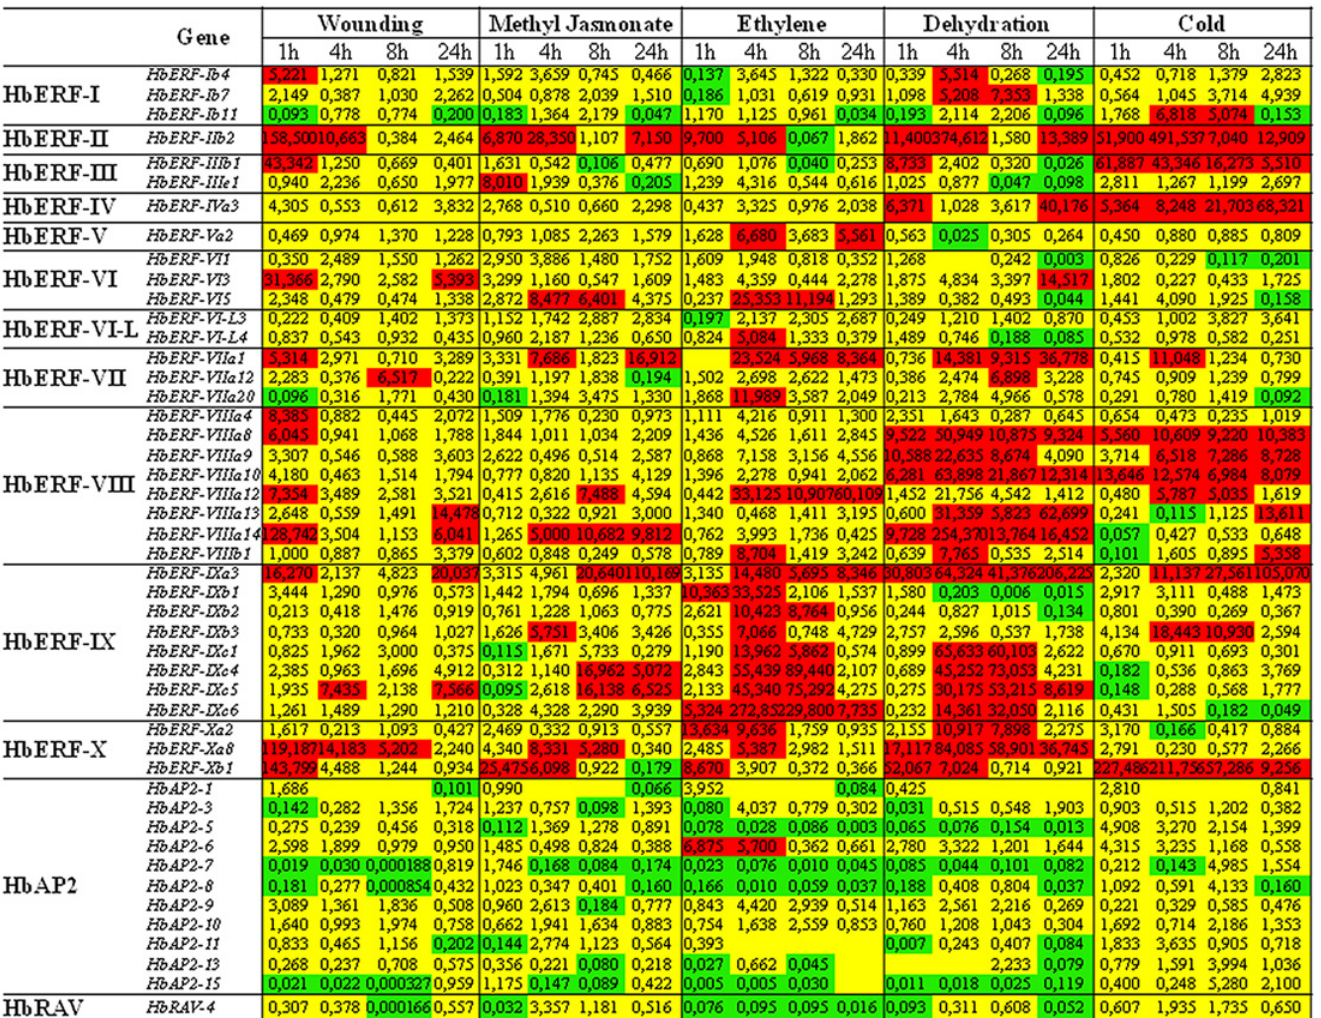
Fig 3. Gene regulation profile of 47 AP2/ERF genes of Hevea brasiliensis under various types of abiotic stress in leaves of juvenile plants. Up- regulated genes are shown in red with a threshold value (cid:1) 5; down-regulated genes are shown in green with a threshold value (cid:3) 0.2. The non-significant genes are shown in